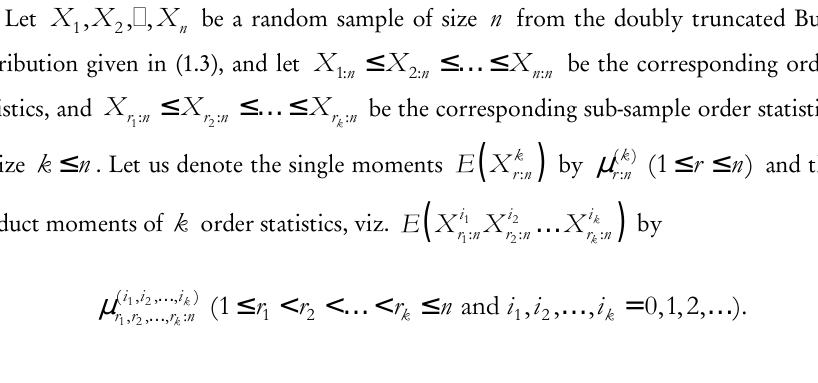
Figure 2 – Doubly Truncated Burr type XII Distribution with